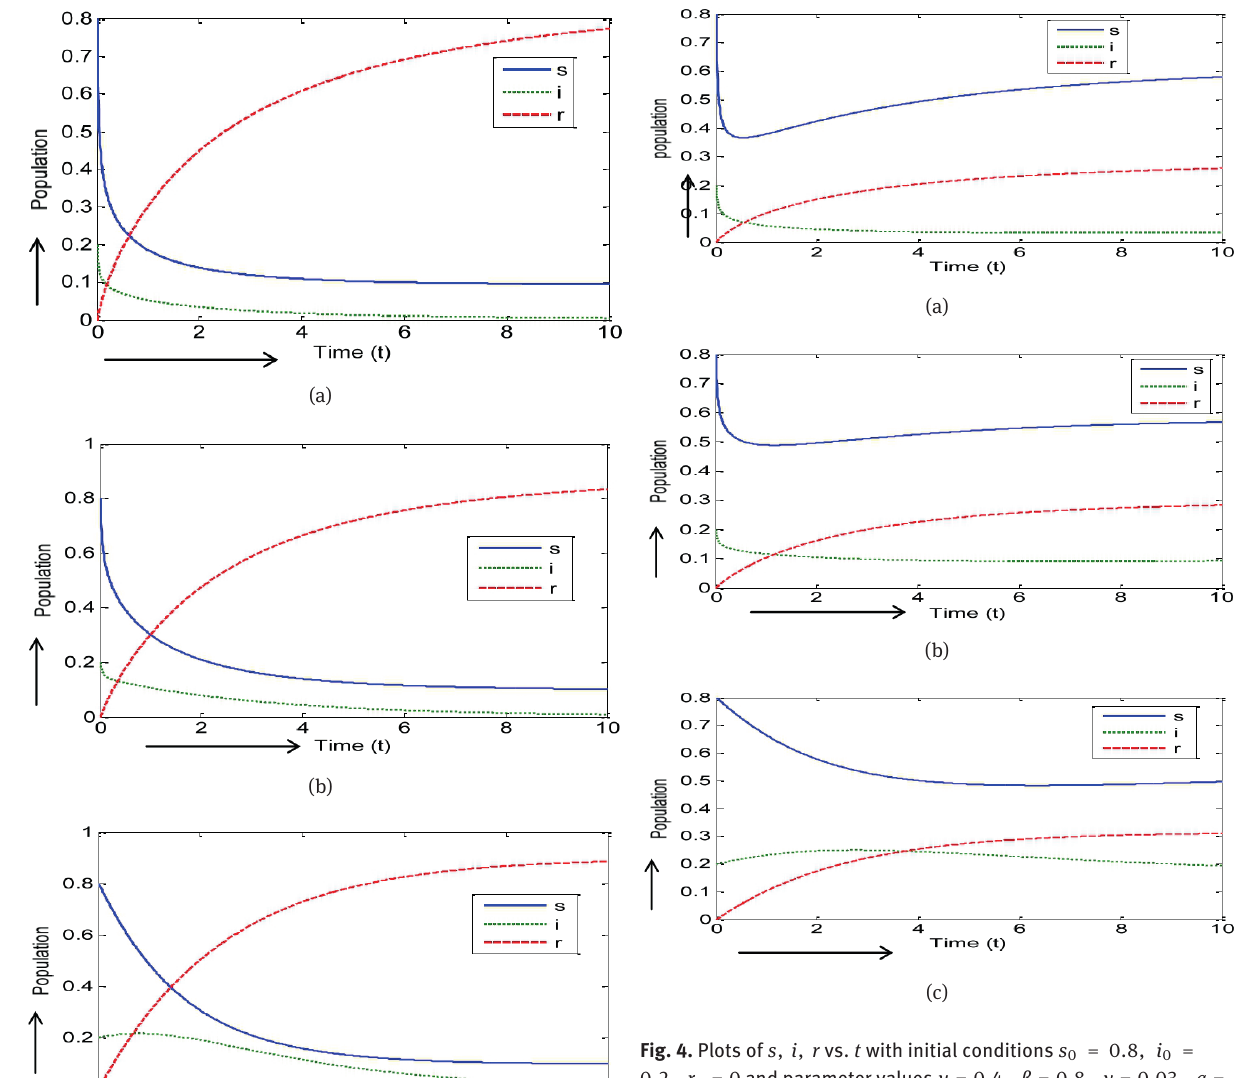
Fig. 4. Plots of s , i , r vs. t with initial conditions s 0 = 0.8, i 0 = 0.2, r 0 = 0 and parameter values μ = 0.4, β = 0.8, γ = 0.03, q = 0.3 when (a) α = 0.8 (b) α = 0.9 (c) α = 1 .